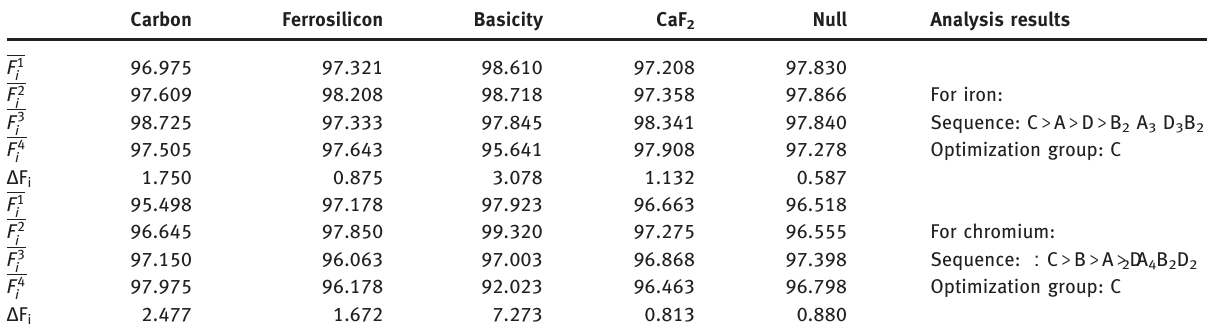
Table 5: Range analysis results for SSD briquette iron-bath reduction process.